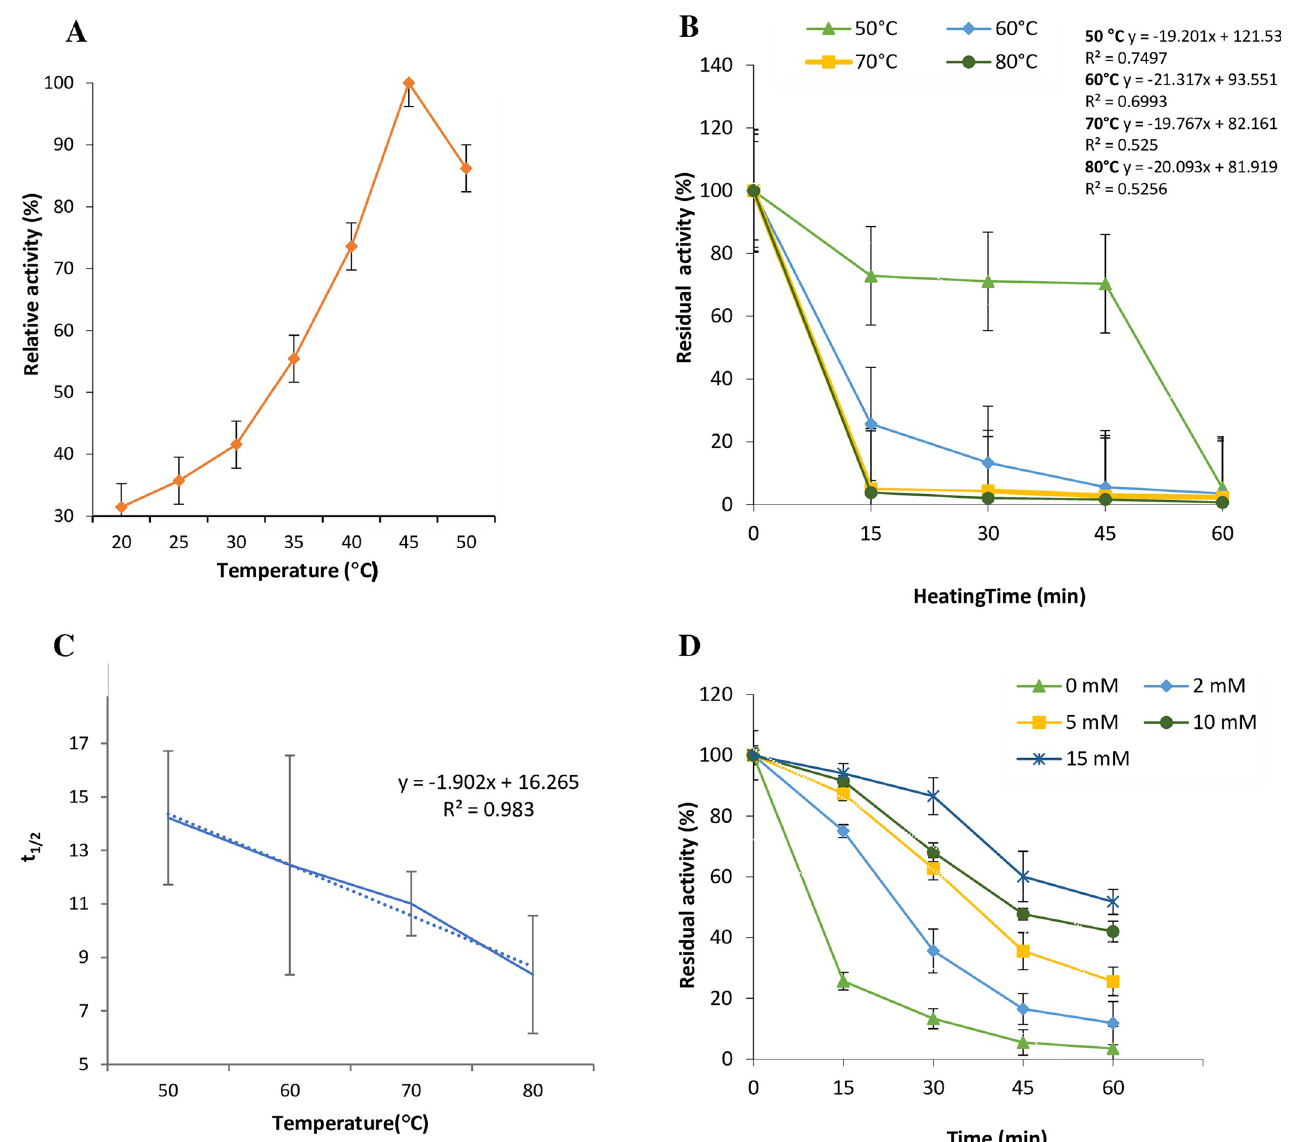
Fig 3. Relation of reaction temperatures to elastase activity (A) and stability (B). The calculated half-lives (t 1/2 ) are presented in Panel C and the effect of calcium ions on elastase thermostability is shown in Panel D.